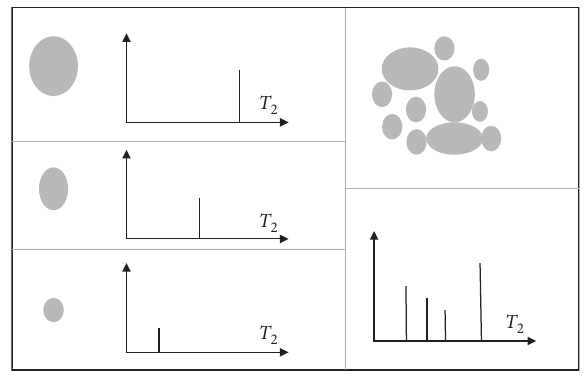
Figure 1: Pore characteristics and relaxation characteristics (according to the data in Figure 1 in [9], it was redrawn with the new algorithm in the